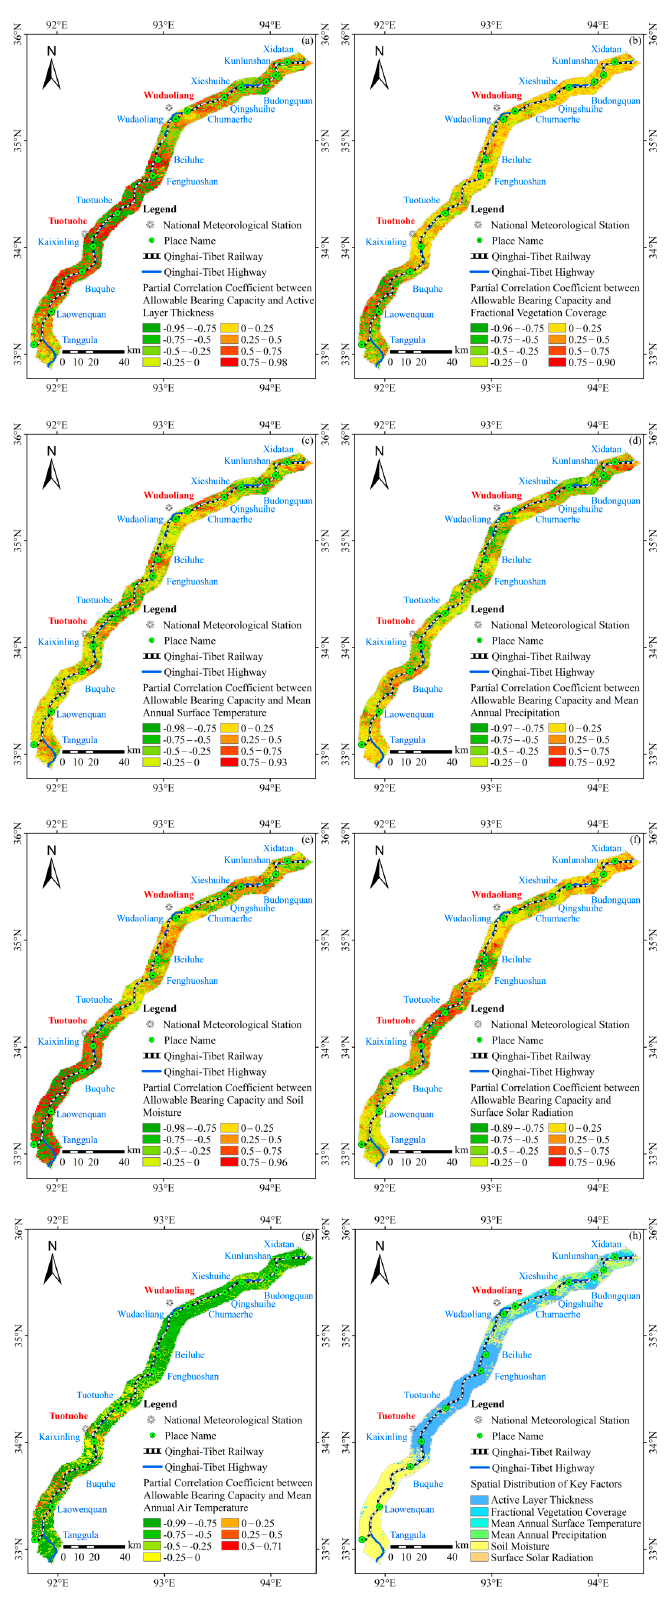
Figure 13. Spatial distribution of the partial correlation coefficient between ABC and driving factors, and key factors affecting ABC: ( a ) ALT; ( b ) FVC; ( c ) MAST; ( d ) MAP; ( e ) SM; ( f ) SR; ( g ) MAAT; ( h ) key factors.